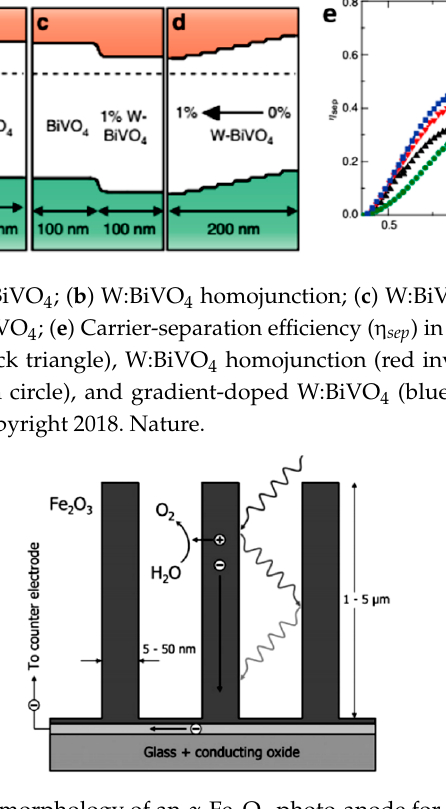
Figure 12. Illustration of the morphology of an α -Fe 2 O 3 photo-anode for water splitting. The small diameter of nanowires ensures short hole diffusion path lengths. Reprinted with permission from ref. [39]. Copyright 2008. The Royal Society of Chemistry.